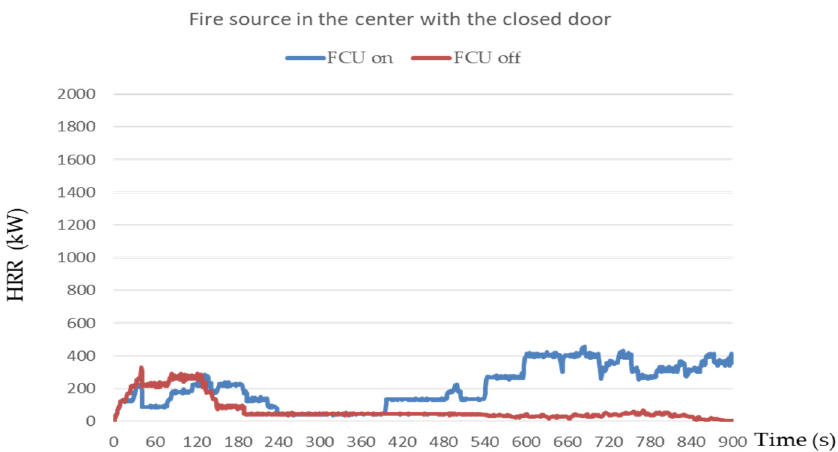
Figure 13. The HRR for different actions of the air inlet with the fire in the center of the square room.